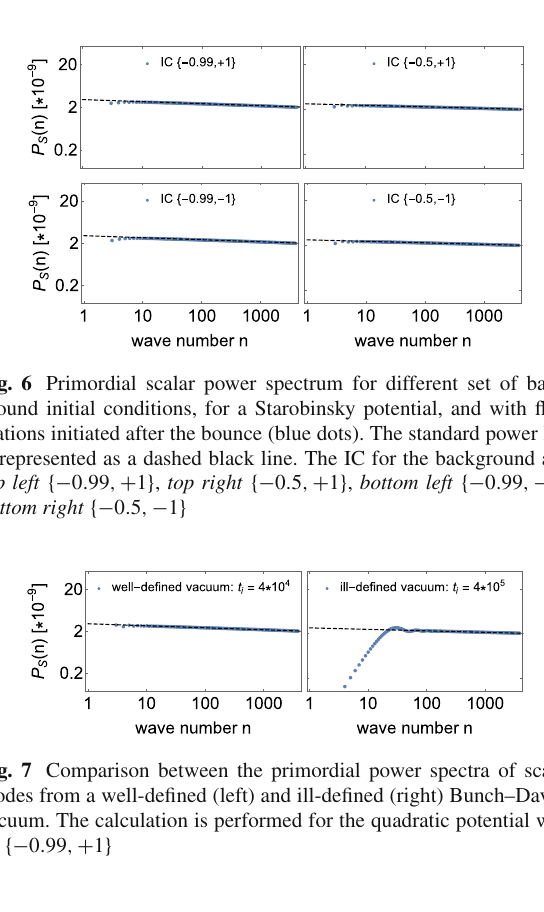
The comparison between the power spectra initiated from a well-definedandanill-definedBunch–Daviesvacuumforthe quadratic potential with background IC {− 0 . 99 , + 1 } is show on Fig. 7. A significant deficit of power for the ill-defined vac- uum, similar to the one of [12], is indeed observed. We do not show the temperature anisotropies for the primordial power spectra shown in Figs. 5 and 6, since they are the same as in the flat space